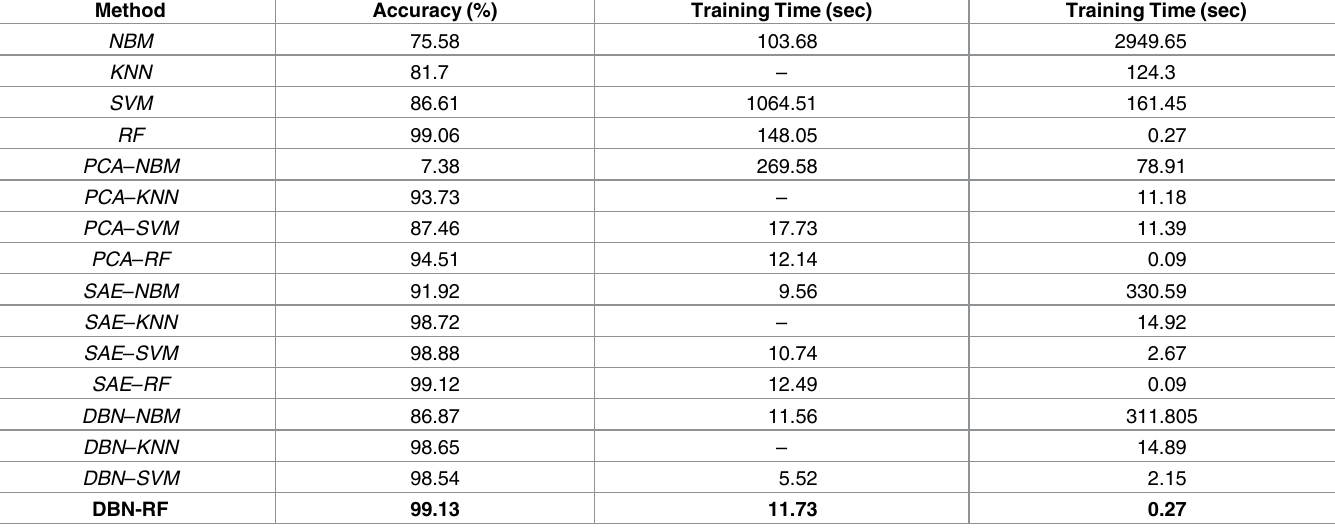
Table 3. Comparison of the training time and forecasting accuracy(training 40%, testing